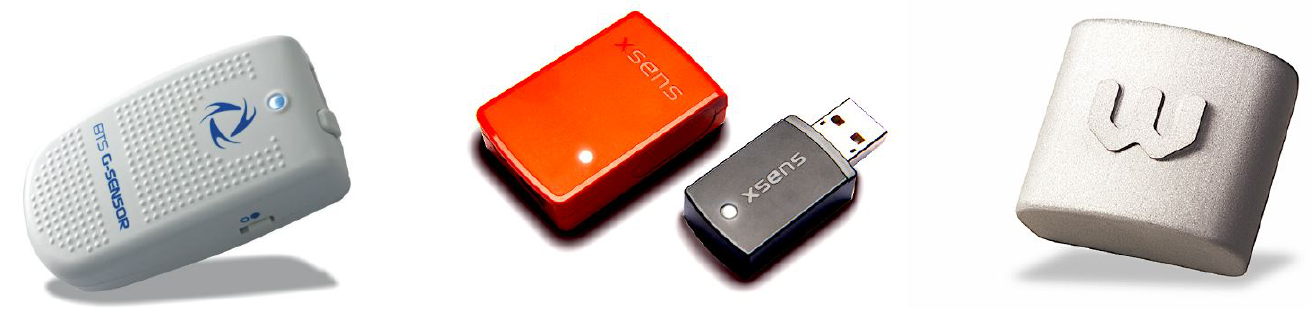
Figure 1. Image of BTS ( left ), MTw ( middle ), and WIVA ( right